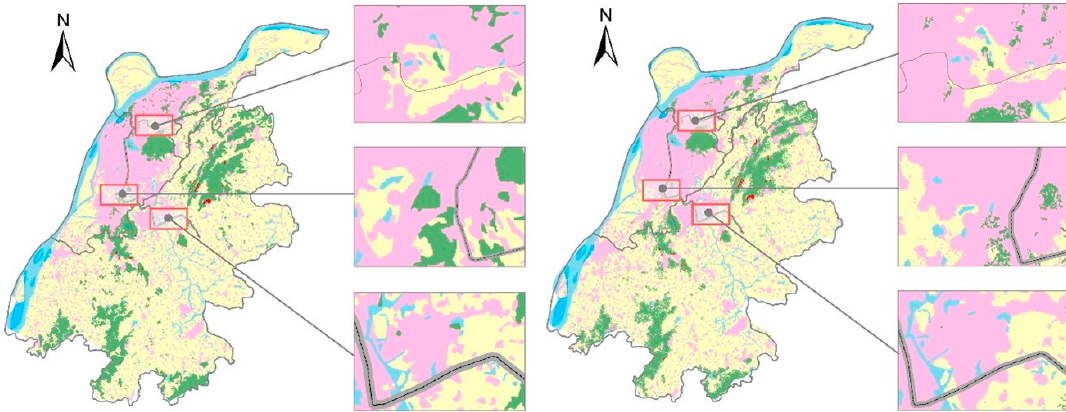
Figure 10. Comparison of the simulated results: left: without considering the LRT influence, right: LRT influence (the proposed model).